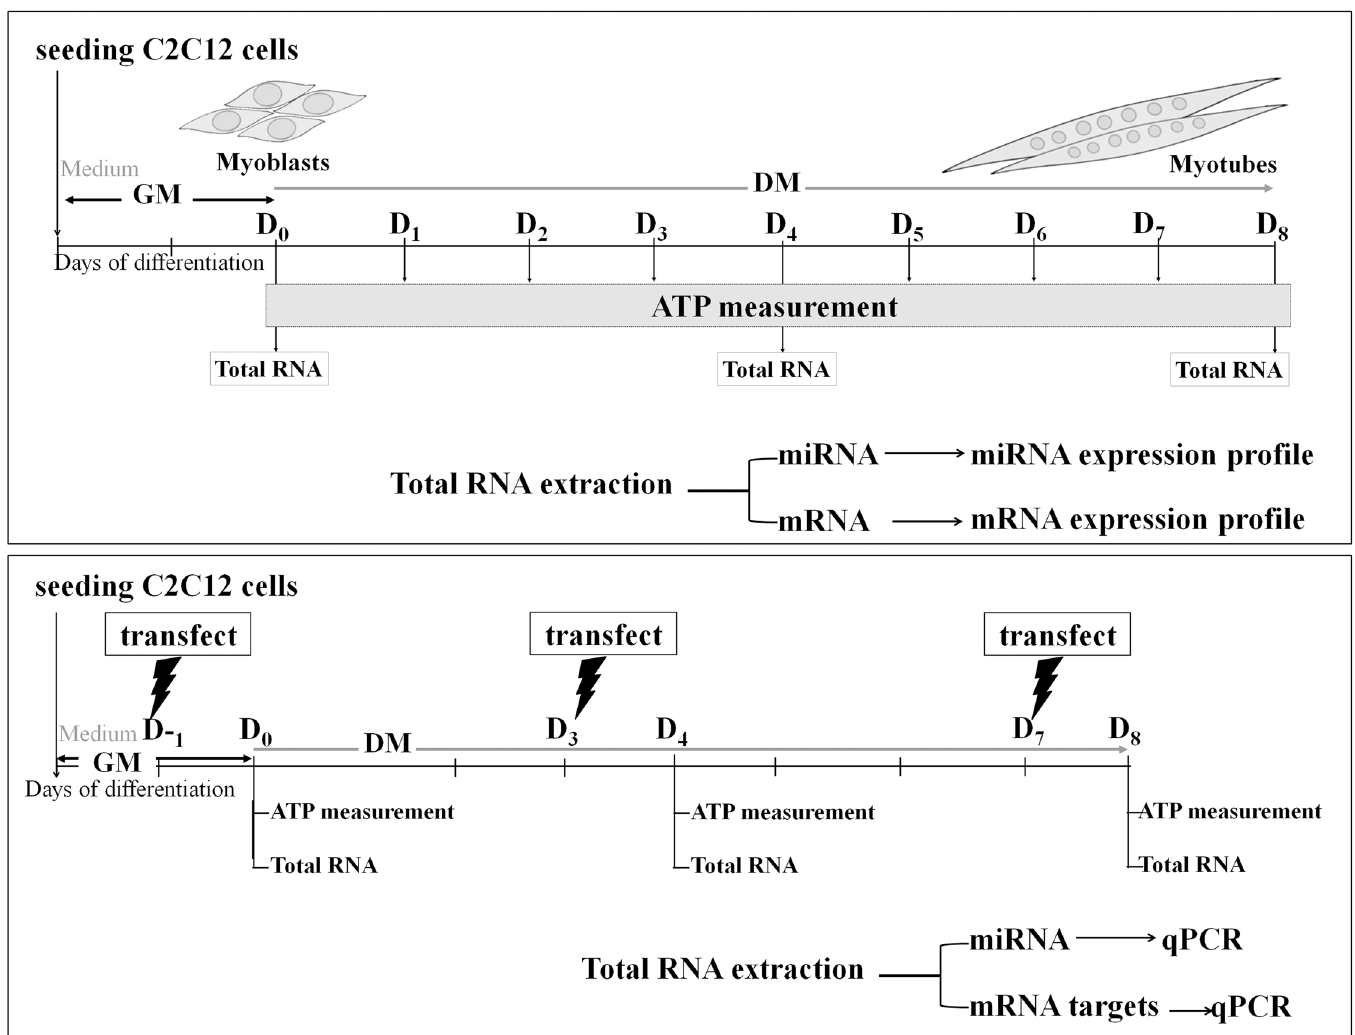
Fig 1. Experimental scheme. (A) ATP measurement and expression profiling of microRNA and target mRNA. C2C12 myoblasts were maintained in growth medium (GM) for 2 days (80 – 90% confluence). Myogenic differentiation was then induced from D0 to D8 by switching to differentiated medium (DM). Cells were harvested for (1) intracellular ATP measurement (2) expression profiling of miRNA (Affymetrix GeneChip miRNA 3.0 Array) and target mRNAs (Qiagen RT2 Profiler PCR Array focusing on mitochondrial energy metabolism genes). (B) miR-423-3p overexpression by transfection of synthetic miR-423-3p mimic. C2C12 myoblasts were transfected with miR-423-3p mimic 24 hours prior to myotube induction (D -1), D3 and D7 post-induction and were then collected on D0, D4, and D8, respectively, for miRNA and target gene qPCR as well as ATP